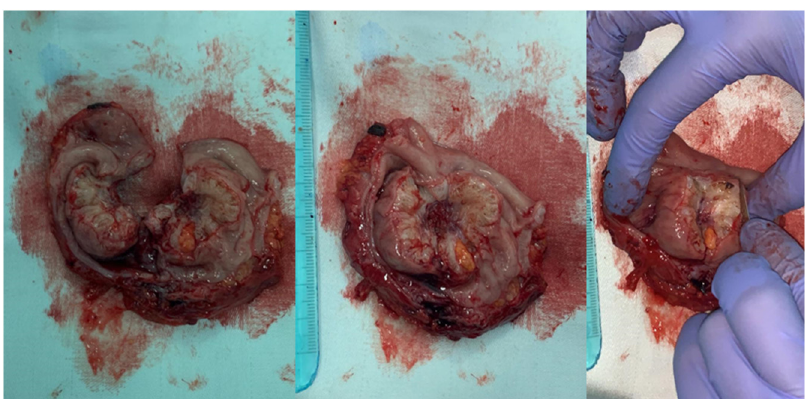
Figure 1. Sigmoid colon endometriosis—macroscopic aspect of the piece after laparoscopic resection using a circular stapler (personal collection, L. Pirtea).